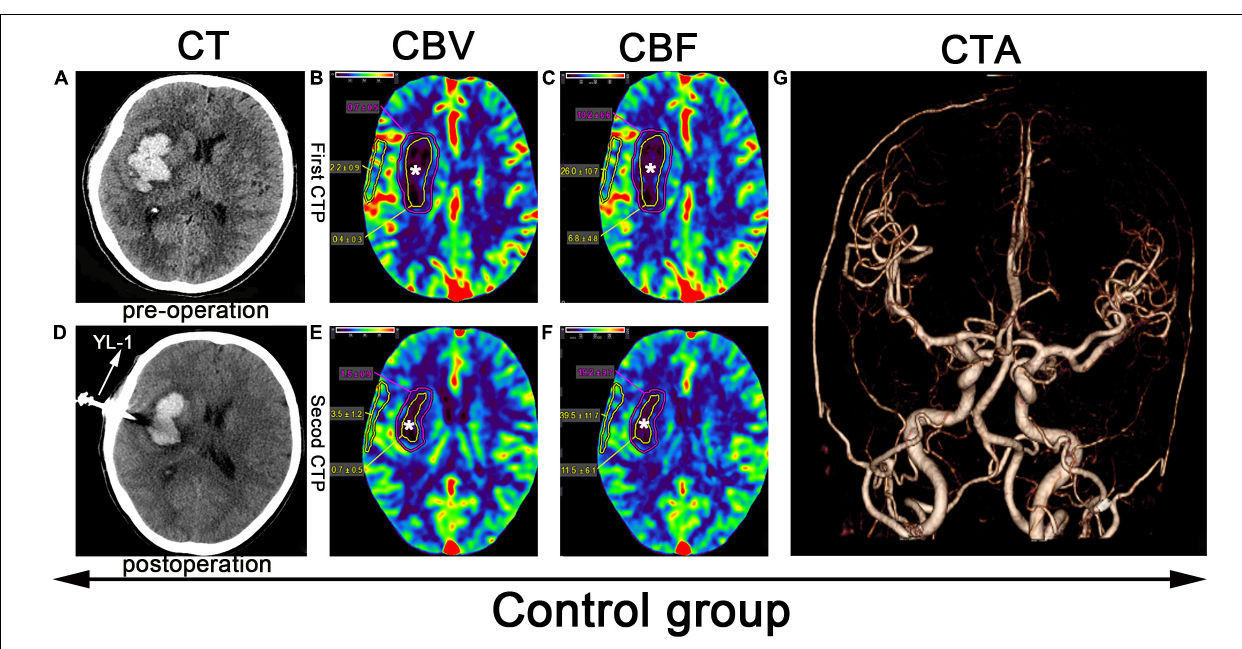
FIGURE 3 | CTP scan from a patient in the control group: (A) Preoperative right basal ganglia hemorrhage. (B,C,E,F) The yellow line denotes the hematoma center area, the white star (*) denotes the hematoma center, and the outer layer yellow line denotes the cortical area of the hematoma. (D) Application of a YL-1 puncture needle after puncture and drainage. (G) Normal